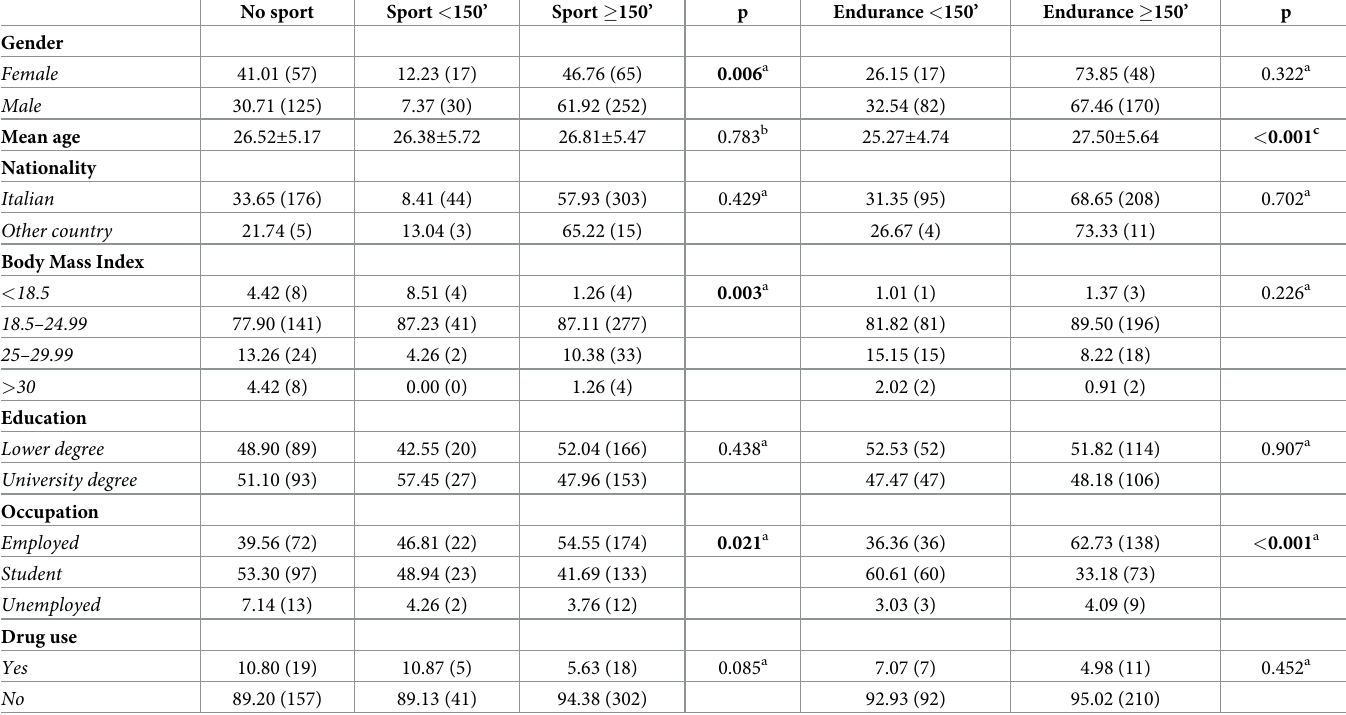
Table 1. Socio-demographic variables of the sample, stratified by minutes of sport activity during the week. Categorical variables are reported as % (Number), while continuous variables are reported as mean ± standard